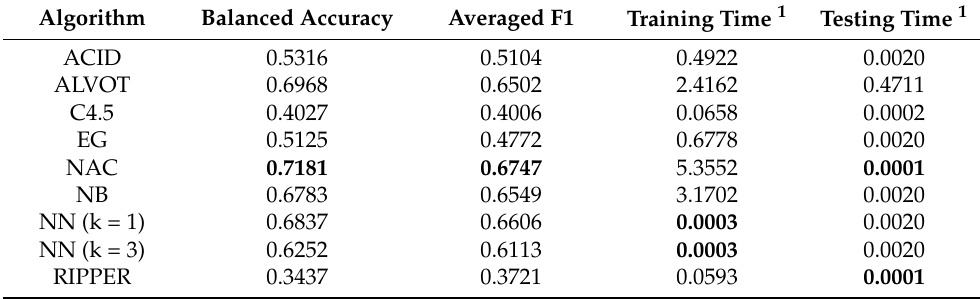
Table 3. Performance of the compared classifiers.